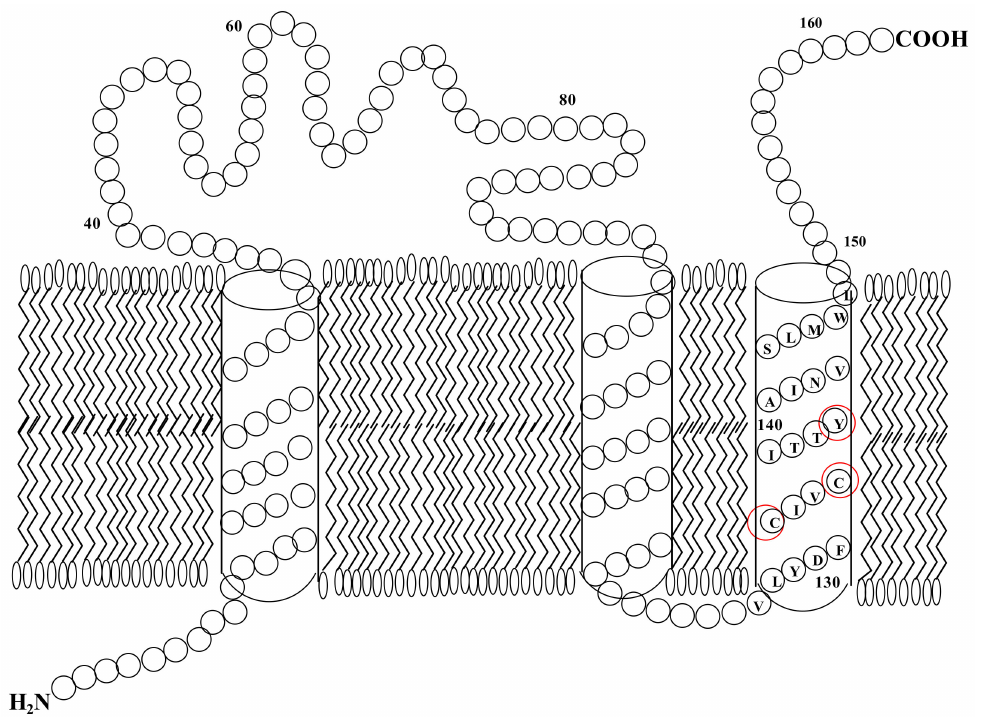
Figure 4. Topology of the VKOR protein, the amino terminus resides in the ER lumen and the carboxy terminus resides in the cytoplasm